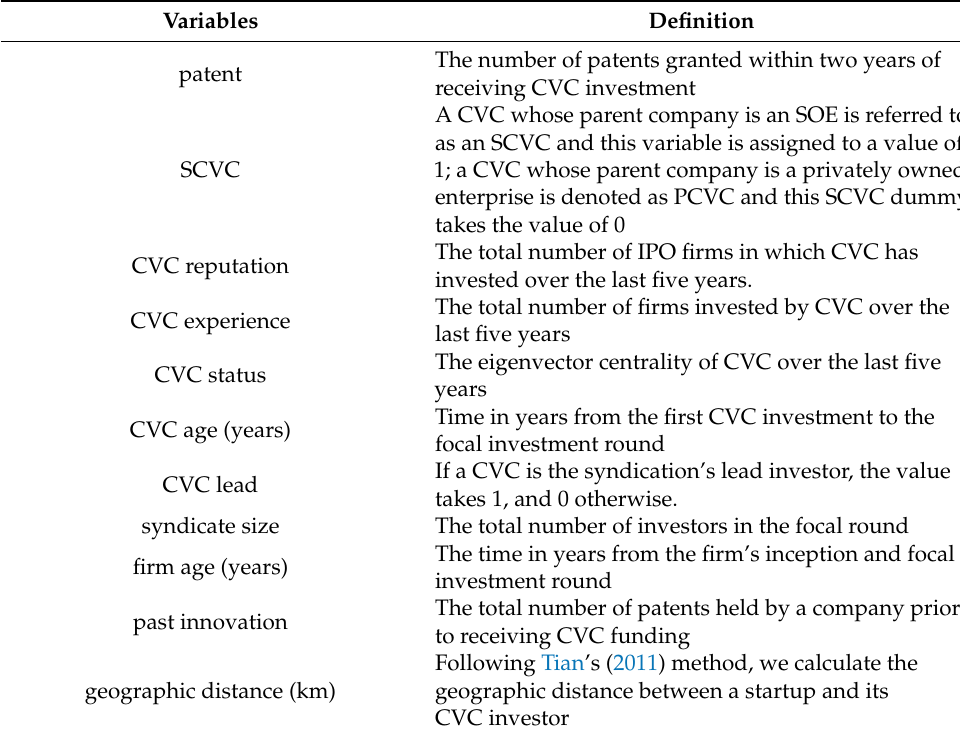
Table 1. Definitions of